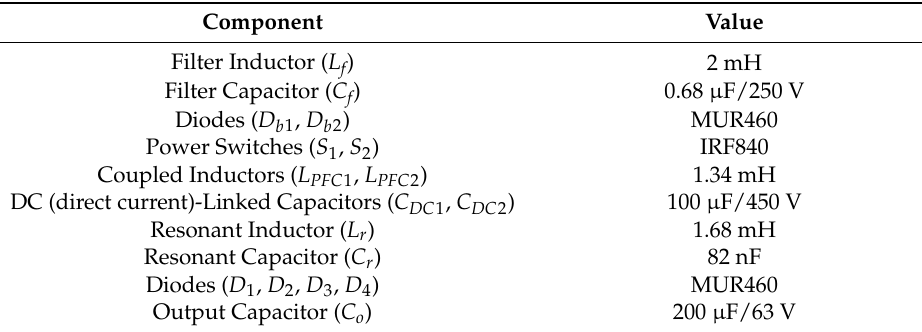
Table 1. Key components used in the presented led tube lamp driver.